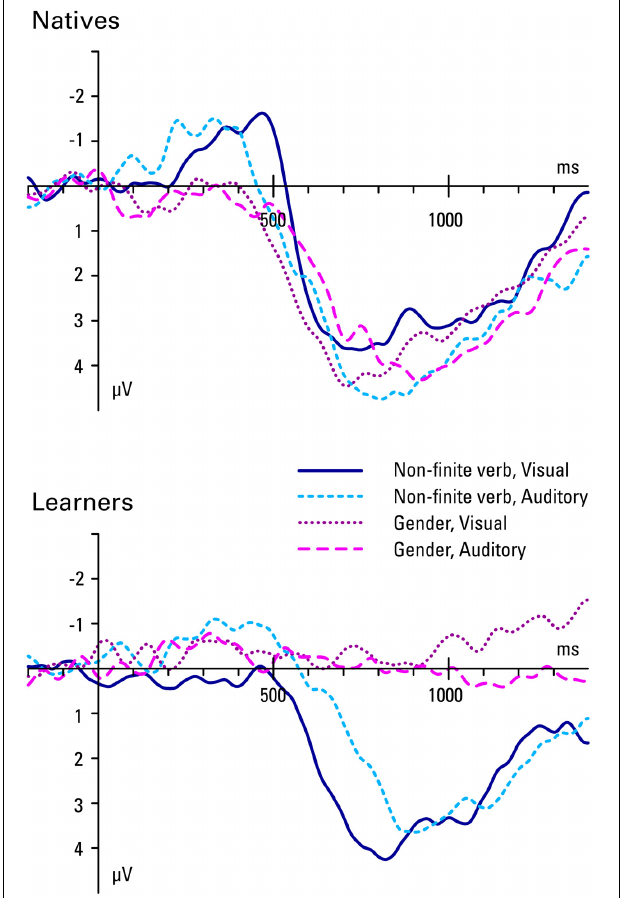
FIGURE 5 | ERP difference waves (incorrect minus correct sentence) per group, structure, and modality, collapsed over middle frontal and all temporal, parietal, and occipital